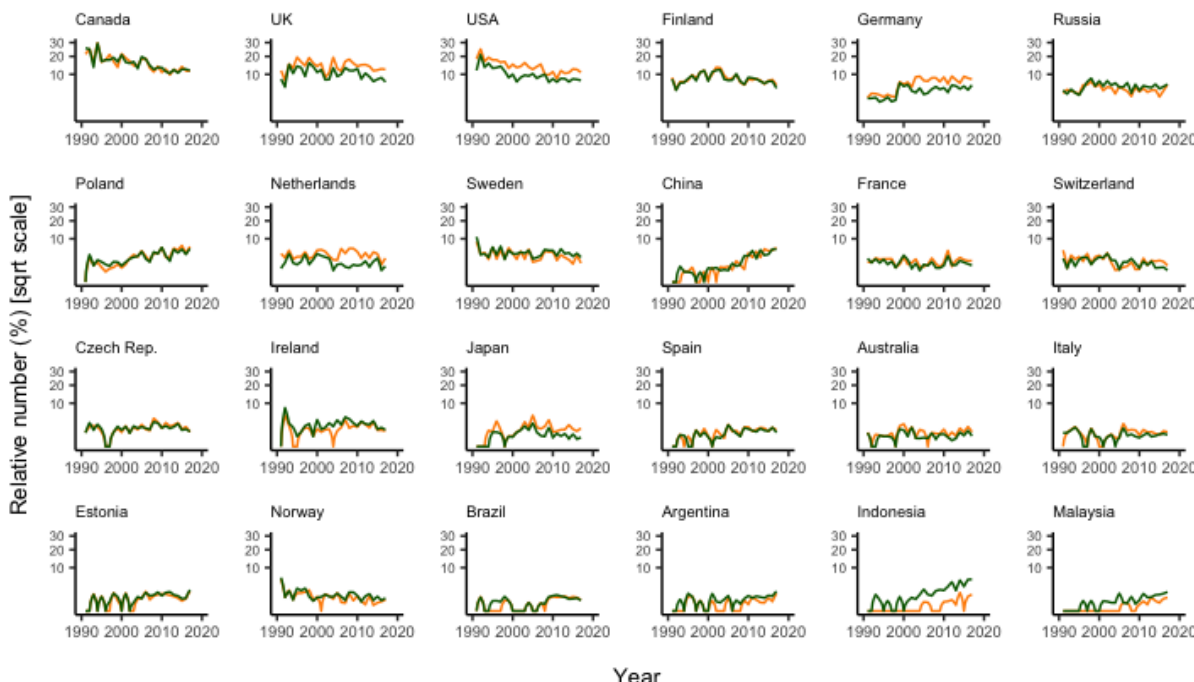
Figure 4. Relative number of articles, to the global total number of articles per year, according to the relative number of articles produced (orange) and the study site (green), for the most productive countries and major southern countries. Relative numbers are shown on a square-root transformed scale. Countries are ordered, from left to right, according to total number of